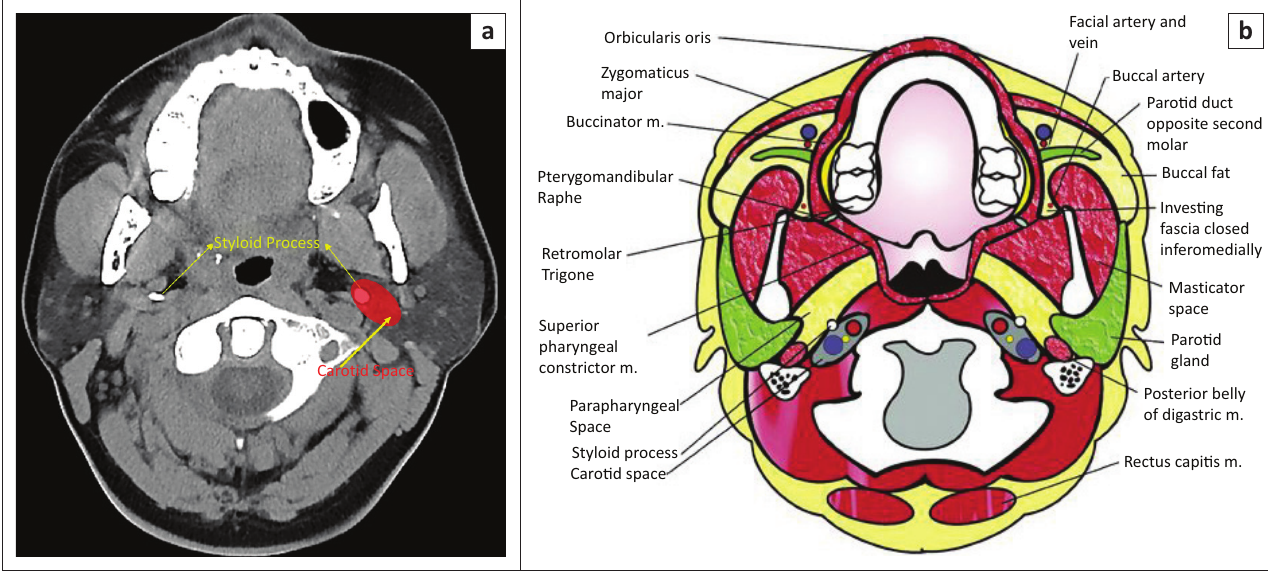
b Facial artery and